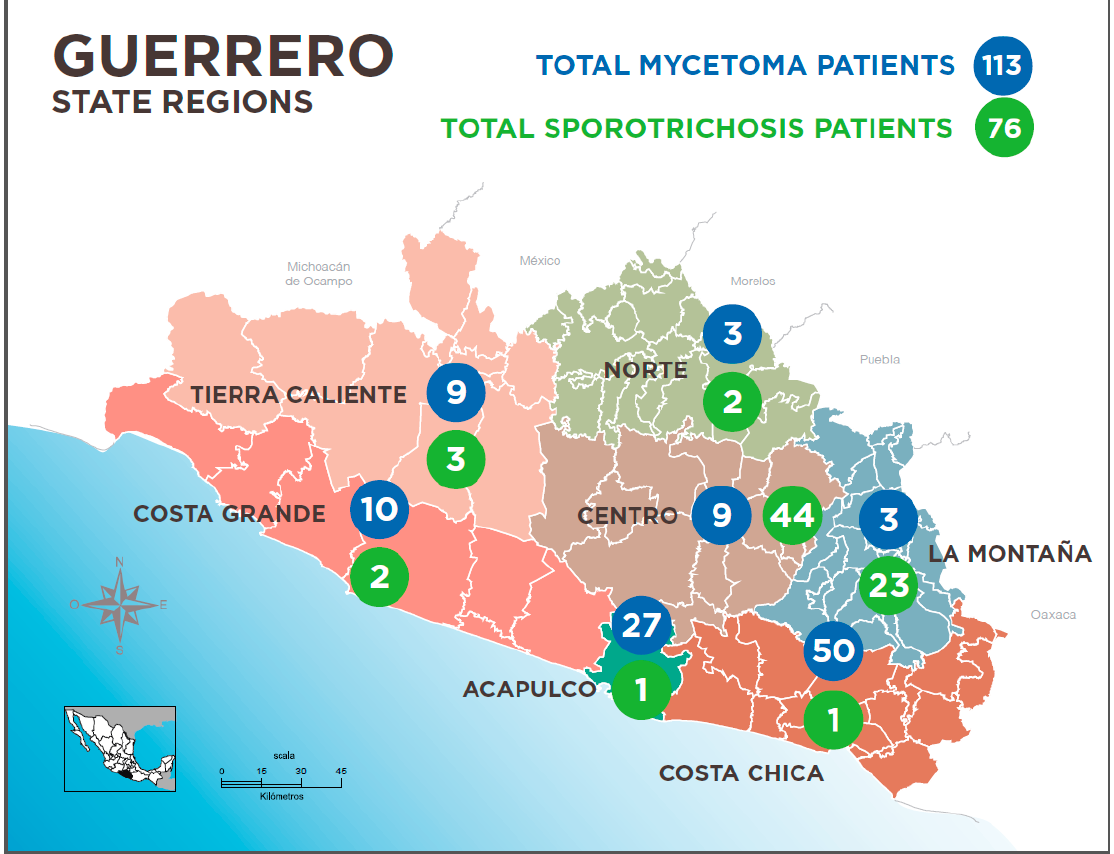
Figure 3. Map of Guerrero State showing cases of mycetoma and sporotrichosis.